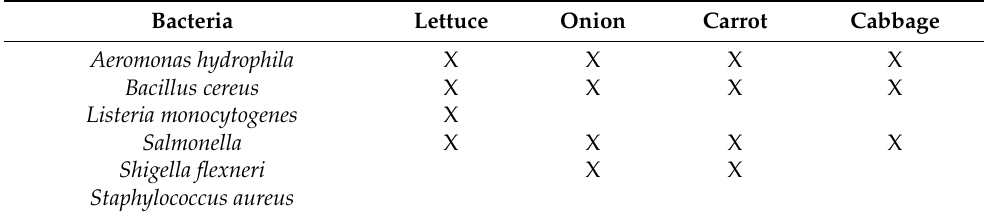
Table 4. Bacteria capable of growing in each horticultural products under study